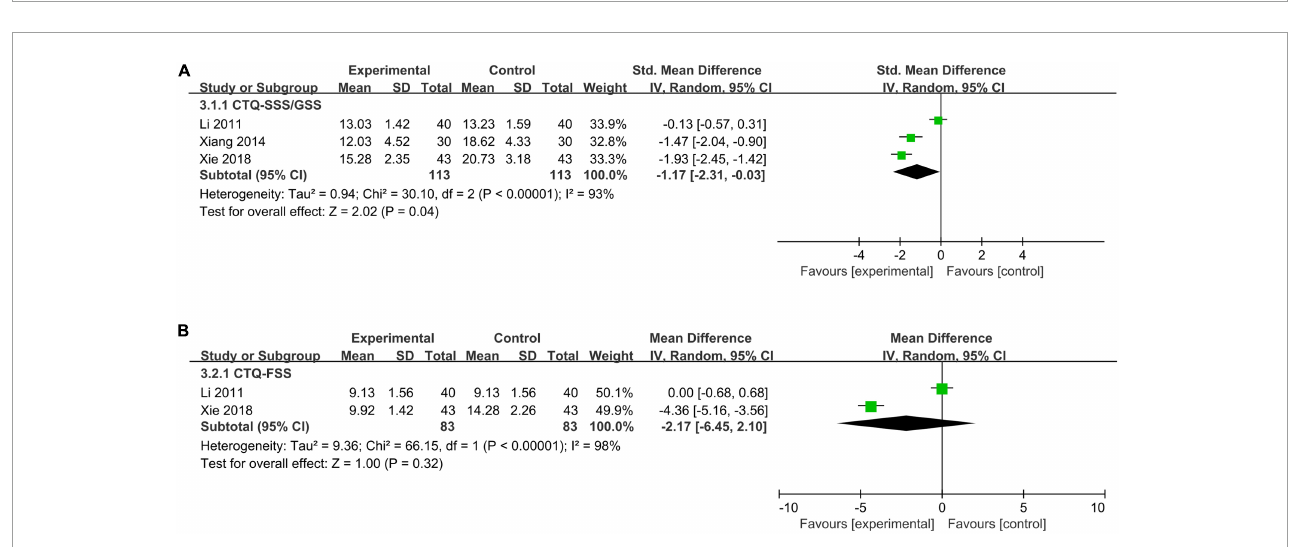
FIGURE6 A meta-analysis of symptom severity and functional status of acupuncture plus medicine vs. medicine. (A) CTQ-SSS/GSS; (B)